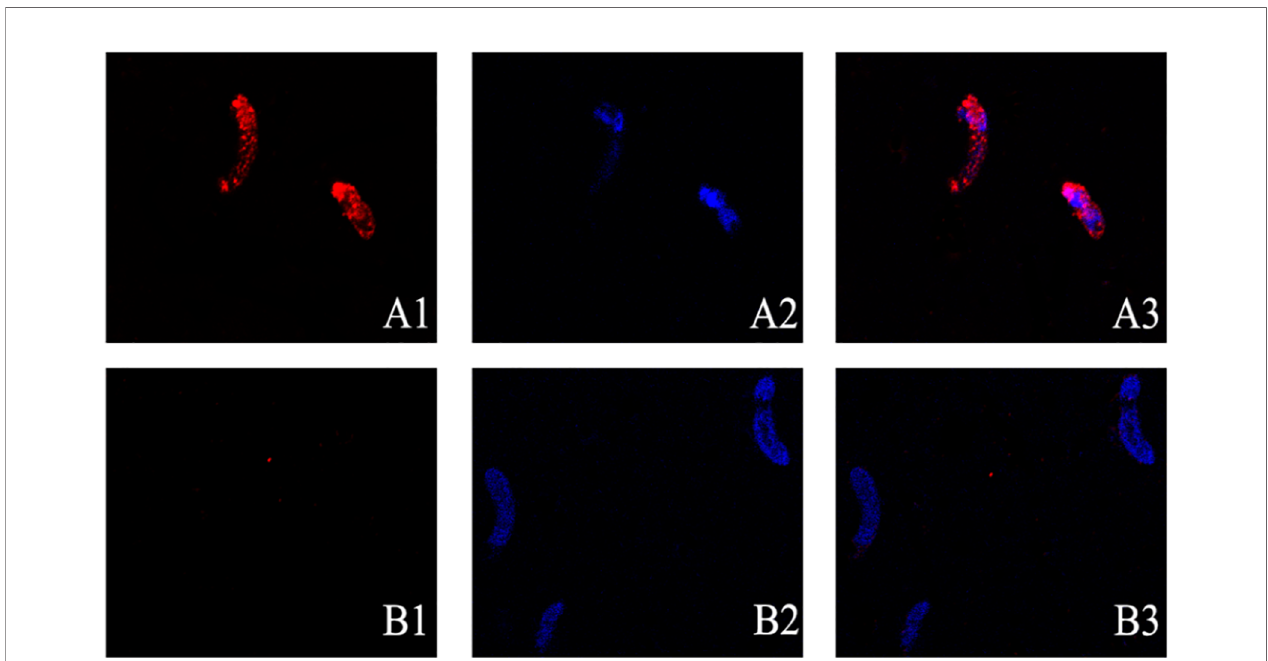
FIGURE 3 | Expression of EmARM- b in sporozoites stage of E. maxima . (A) The sporozoites were detected by anti-rEmARM- b rat serum. A1: Sporozoites were dyed by Cy3; A2: The nuclei were detected by DAPI; A3: Merge. (B) The sporozoites were detected by negative rat antibodies. B1: Sporozoites were dyed by Cy3; B2: The nuclei were probed by DAPI; B3: Merge.